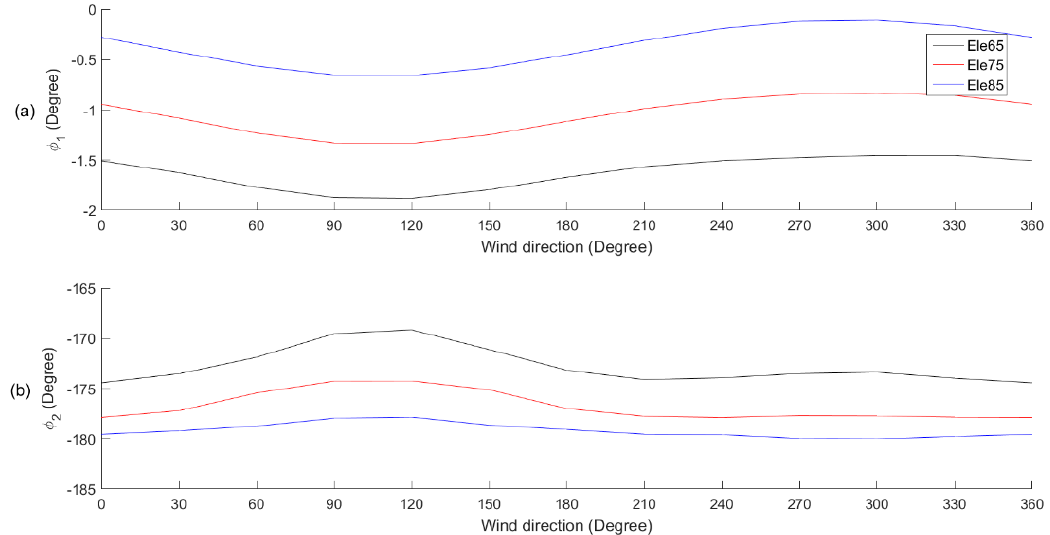
Figure 8. The influence of elevation of the receiver on the relation between wind direction and the angles of ( a ) ϕ 1 and ( b ) ϕ 2 . The wind speed and receiver’s azimuth are 10 m/s and 108 ◦